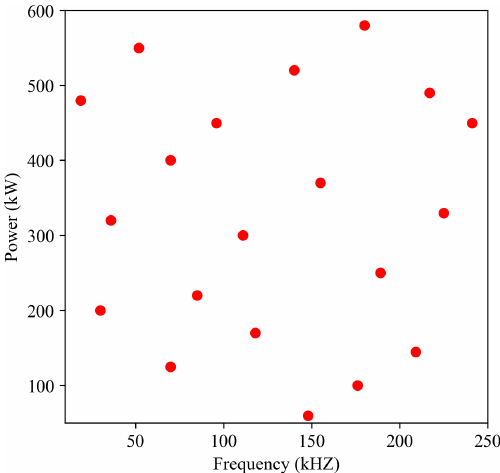
Figure 1. Latin Hypercube Sampling design of experiments.